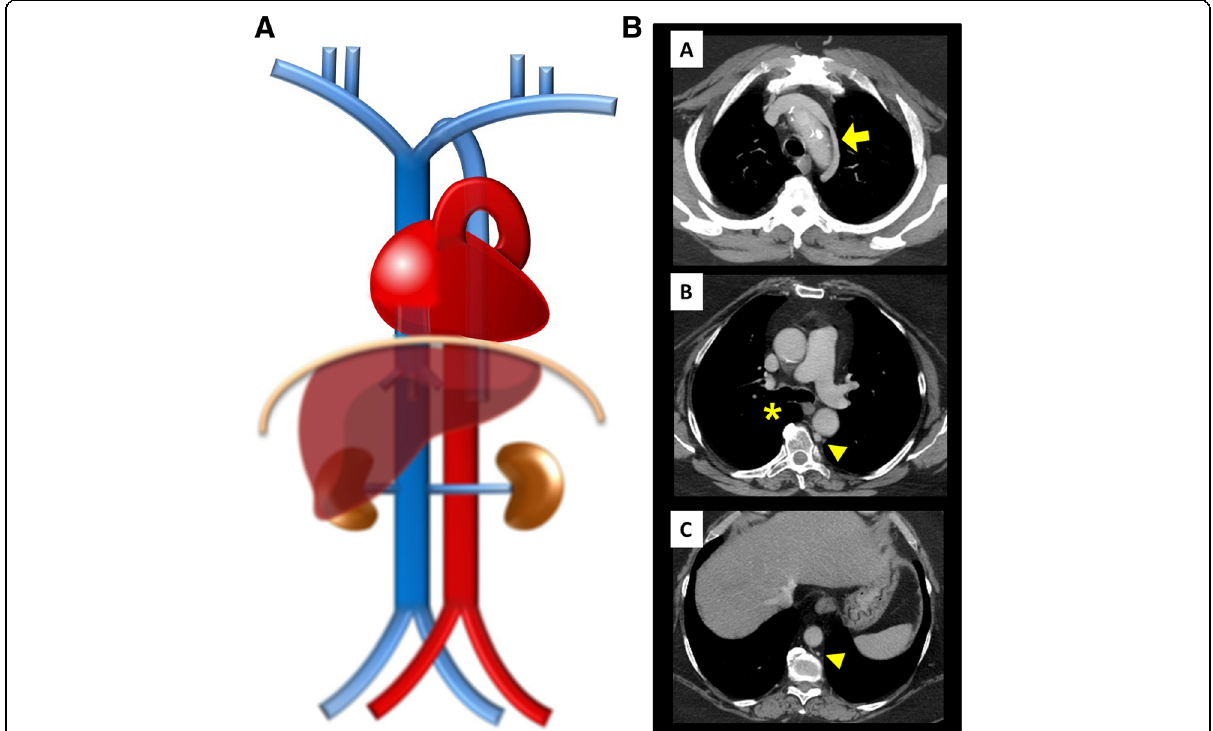
Fig. 16 a Absent azygos vein schematic. Congenital absence of the azygos vein is associated with enlargement of the remaining paravertebral vessels, as the hemiazygos, that serve as a collateral pathway draining usually into the left brachiocephphalic vein. b Absent azygos vein imaging. Contrast-enhanced CT scan denoting an absent azygos vein (asterisk) with enlargement of the hemiazygos (triangle) which drains to the left brachiocephalic vein by an enlarged left superior intercostal vein